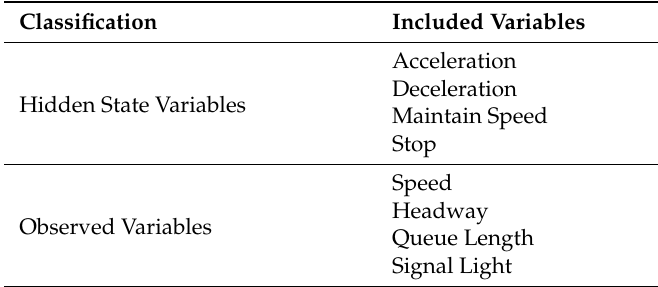
Table 4. Hidden state variables and observed variables chosen in this